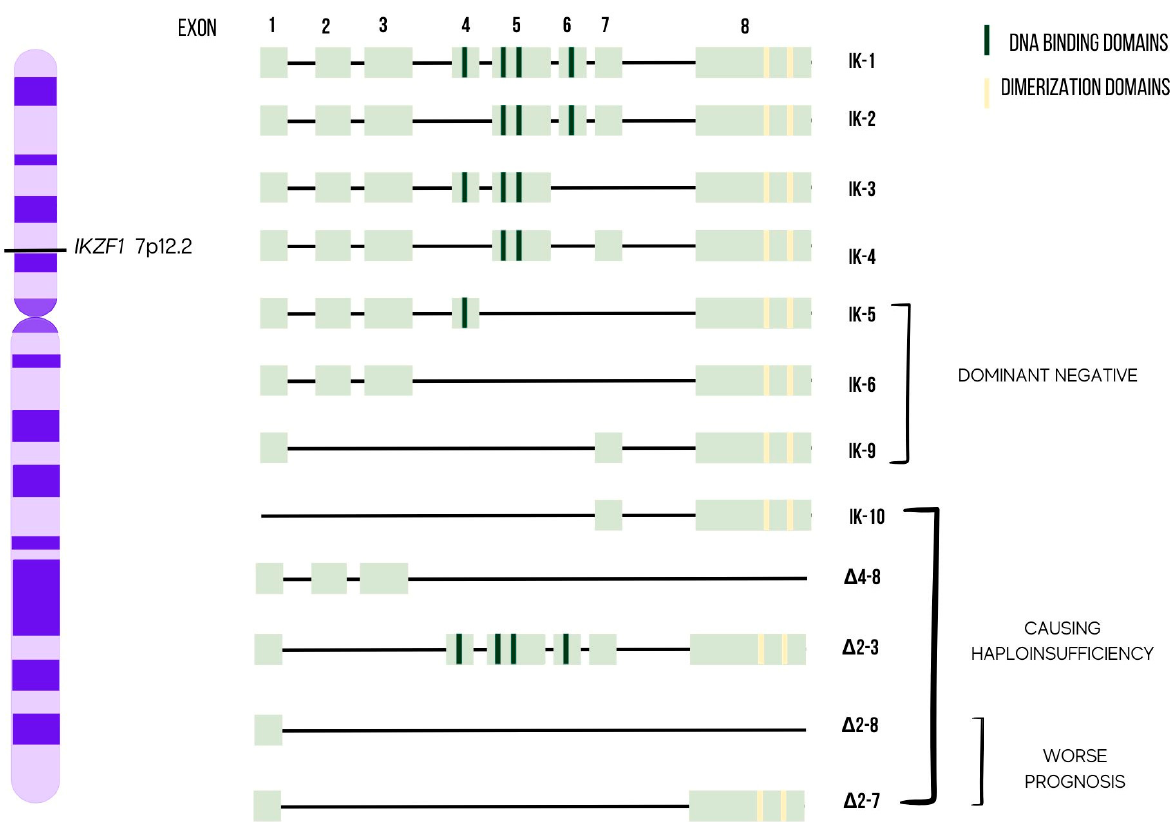
Figure 1. Graphic representation of IKAROS isoforms. The N-terminal zinc fingers are shown in dark green bars and C-terminal zinc fingers are shown in yellow bars. Isoforms from IK-5 to IK-9 are dominant negative (DN) [10], isoforms IK-10, ∆ 4-8, ∆ 2-3, ∆ 2-8, ∆ 2-7 cause haploinsufficiency